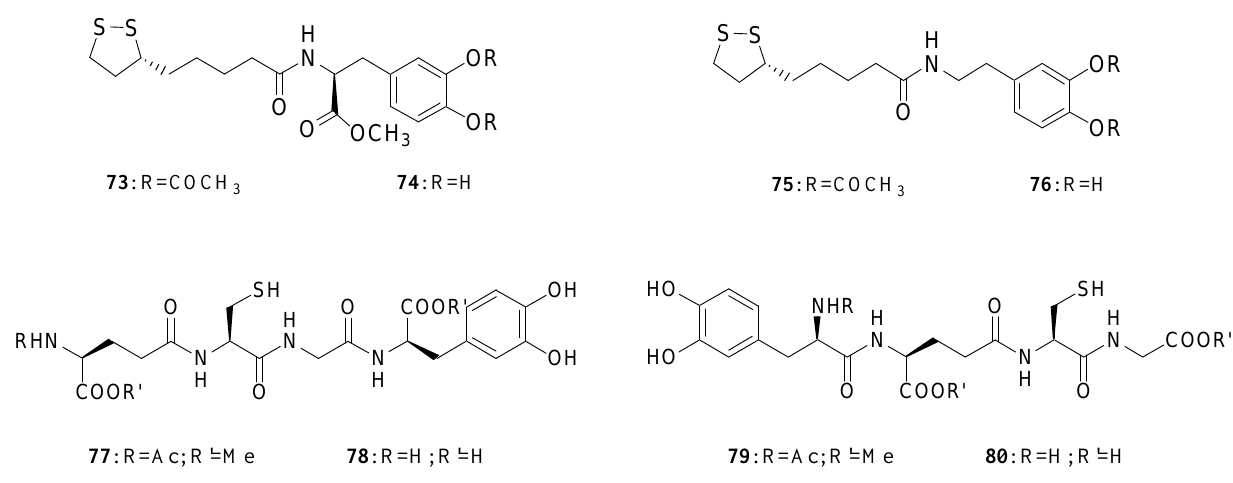
Figure 13 . Multifunctional LD and DA codrugs, containing antioxidant